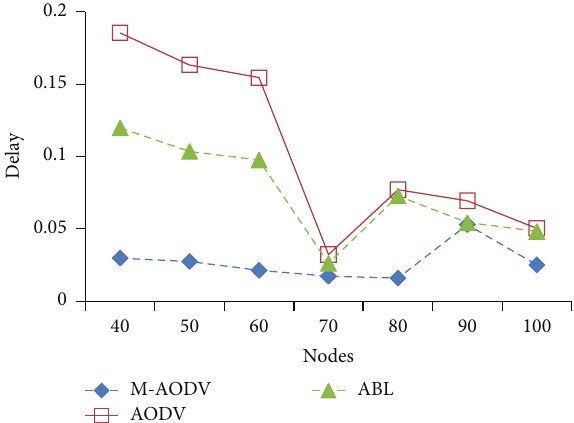
Figure 5: Received packets in second scenario.